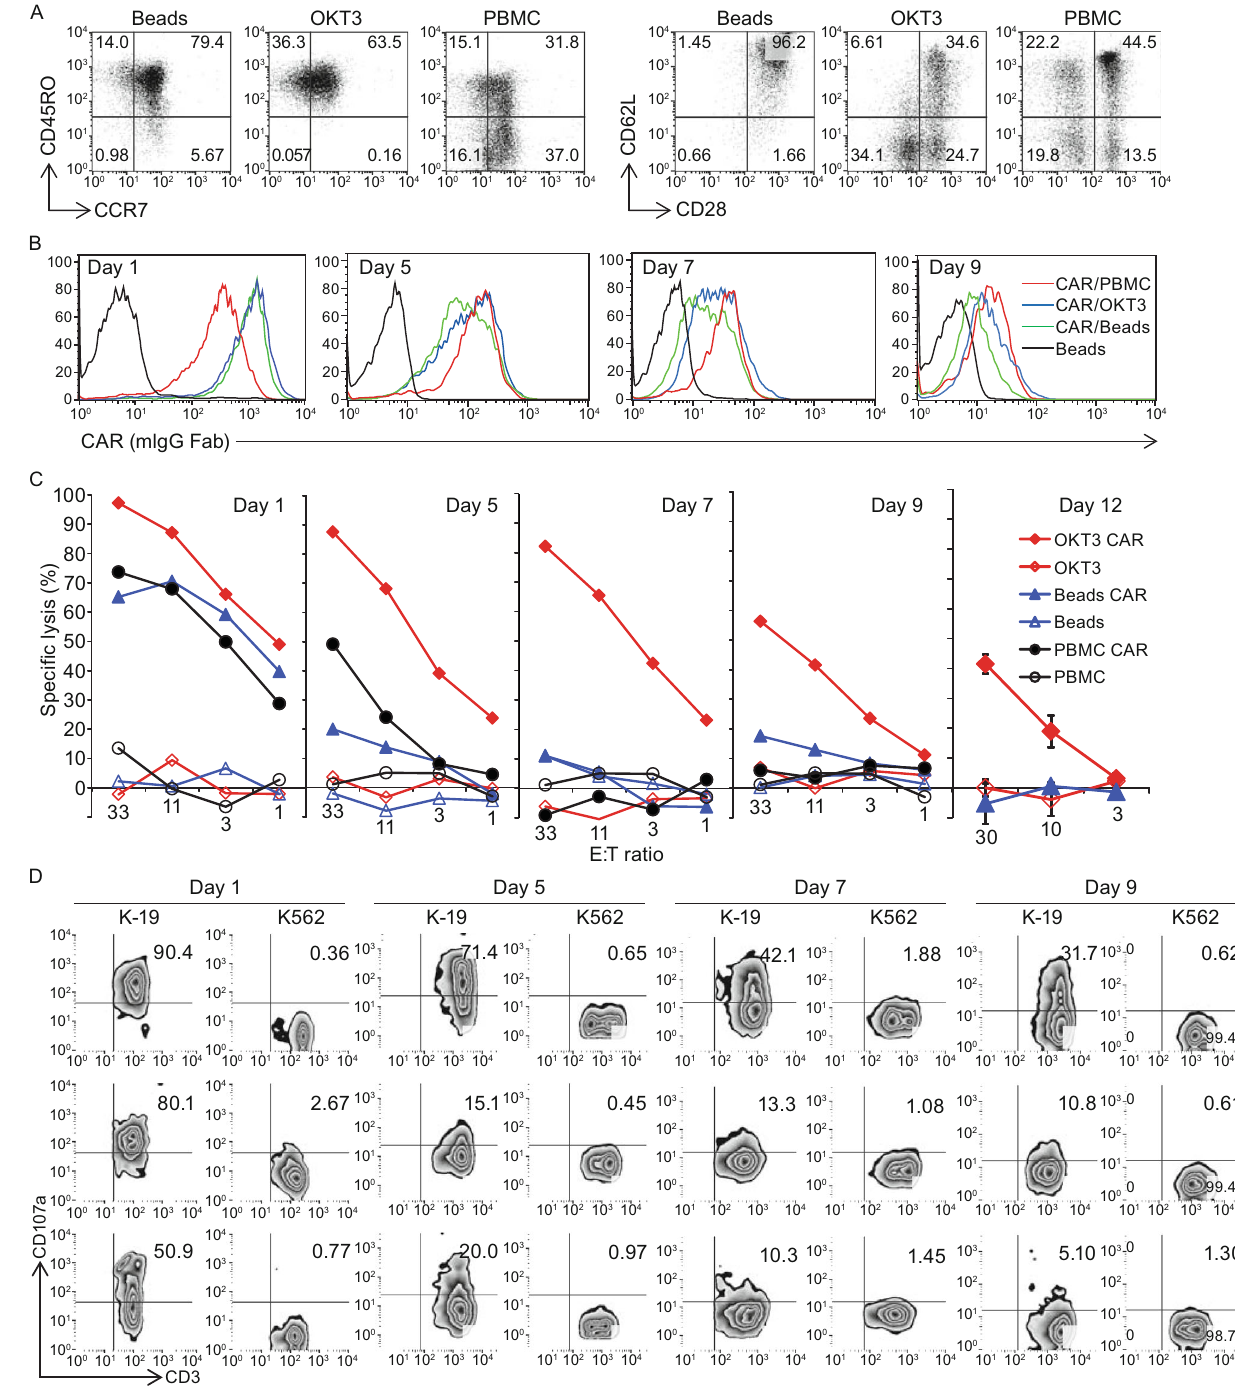
Figure 1. In vitro function comparison of CD3/CD28 Dynabead-stimulated (Beads) and OKT3/IL-2-stimulated (OKT3) T cells. (A) Phenotype of the expanded T cells, compared with T cells from non-stimulated PBMCs. (B) CAR expression of CD19-BBZ CAR RNA-transferred T cells at different time points post-RNA electroporation. (C) Lytic activity against Nalm6 in a 4-h fl ow cytometry- based CTL assay for CAR RNA-transferred Tcells at different time points post-RNA electroporation. (D) CD107a detection of Tcells stimulated by K562-CD19 (K-19) at different time points post-RNA electroporation. (E) Cytokine production of CD19-BBZ CAR RNA- transferred T